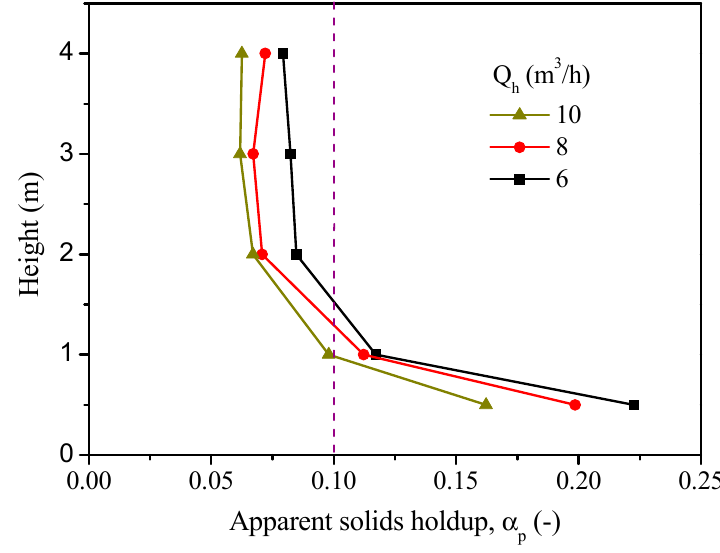
Figure 9. Mean solids holdups as a function of steam flow in different heights.